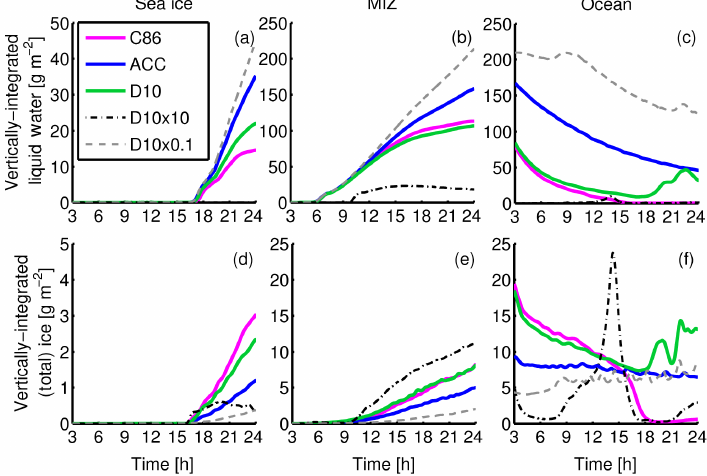
Figure 8. Vertically integrated liquid (a–c) and ice water paths (d–f) for the sea ice, MIZ, and ocean cases when implementing each of the C86, ACC, D10, D10 × 10, and D10 × 0.1 parameterisations under water-saturated